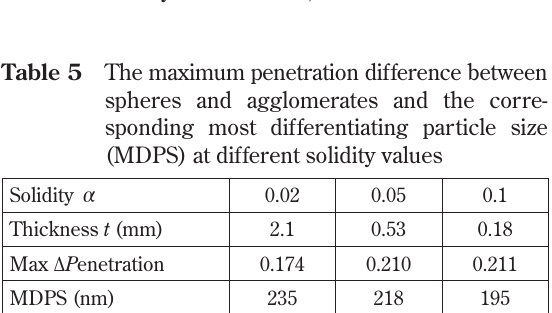
Fig. 11 Penetration values for spherical and agglomer- ated nanoparticles from model calculations for solidity values of 0.02, 0.05 and